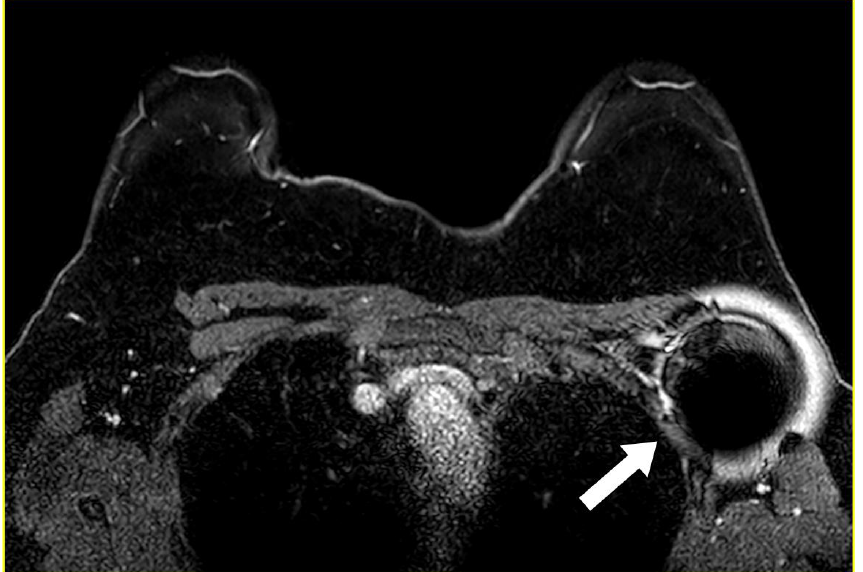
Figure 7. Gradient echo fat-suppressed contrast-enhanced T1-weighted axial image shows the ferromagnetic artifact (arrow) generated by a magnetic seed previously placed in a left axillary lymph node.